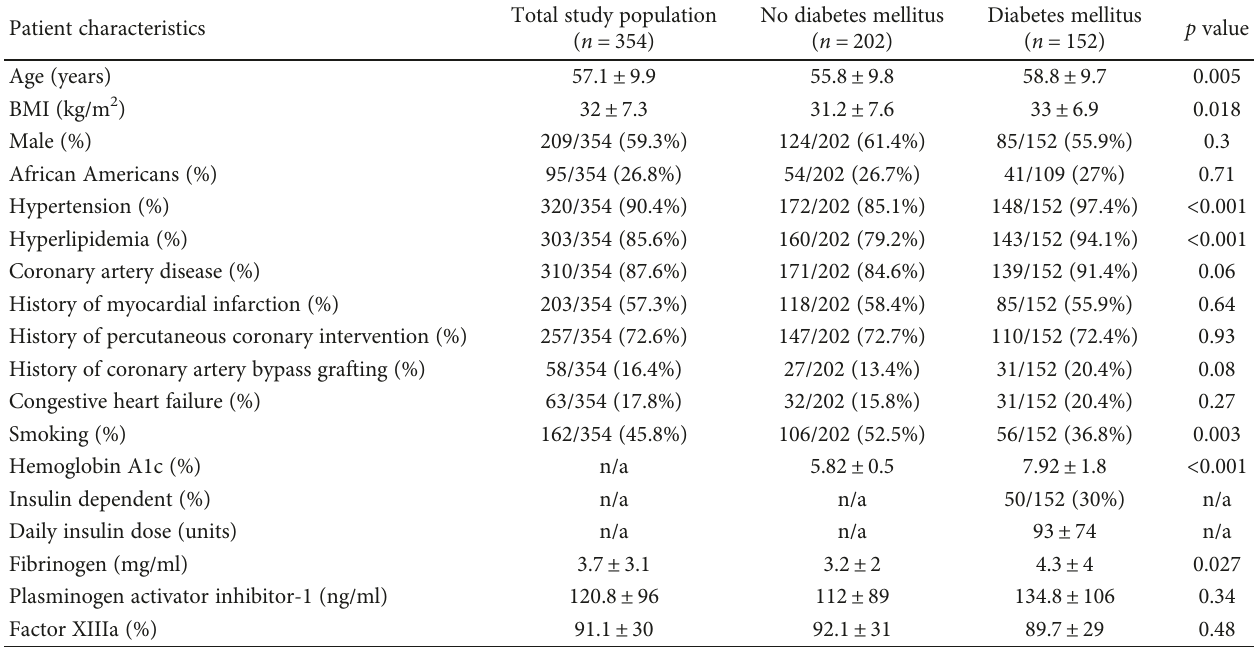
Table 1: Baseline